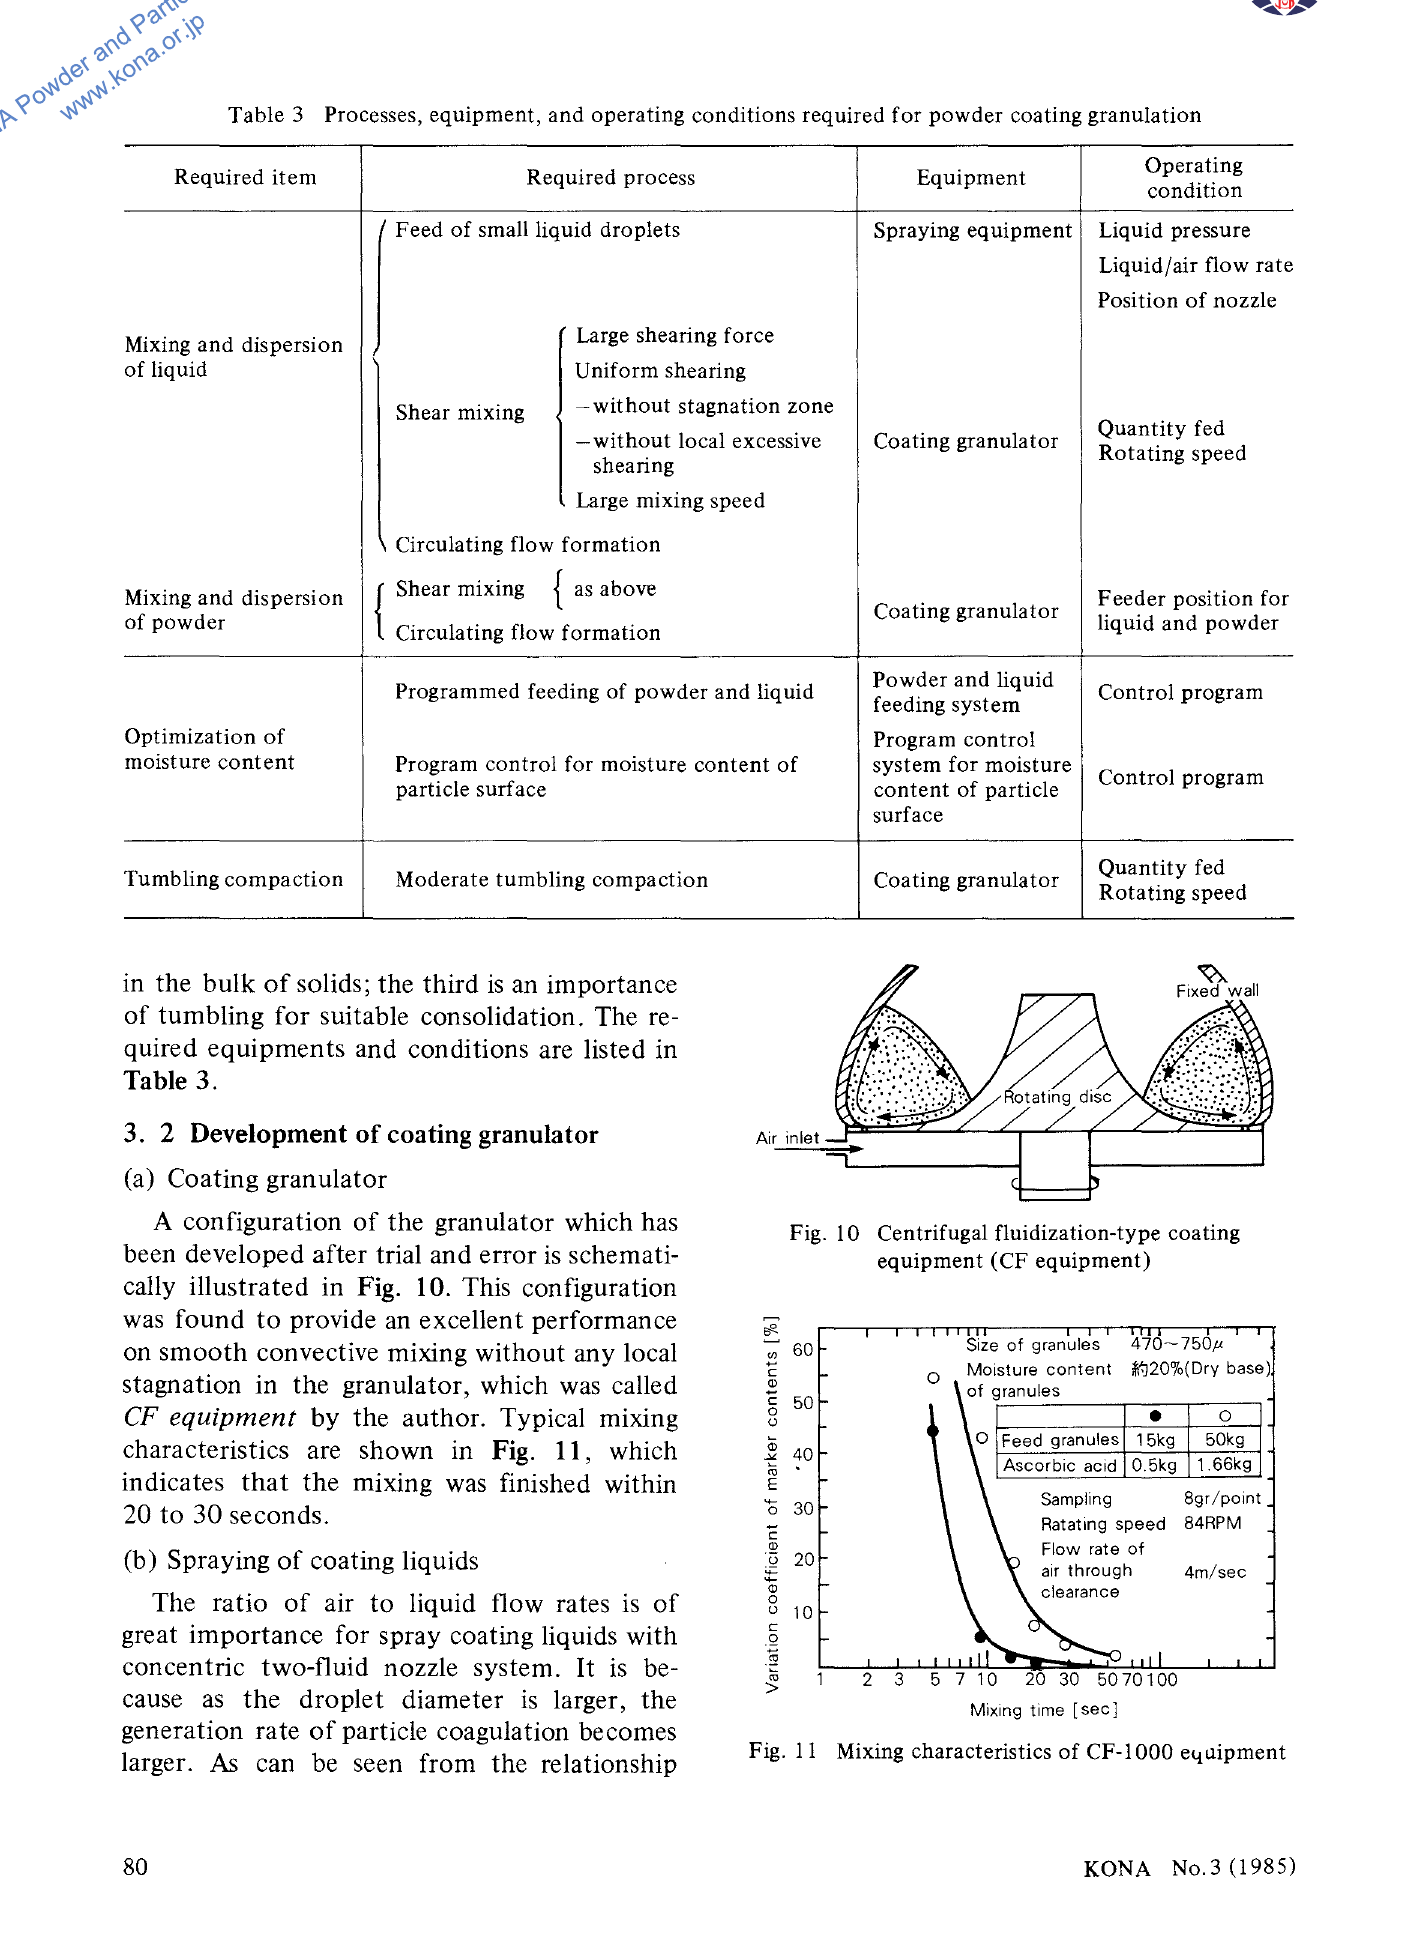
Fig. 11 Mixing characteristics of CF-1 000 e4